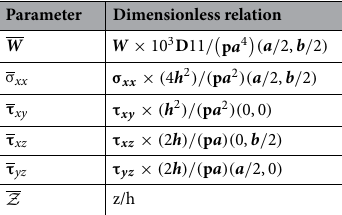
Table 3. Dimensionless relations of mechanical parameters.